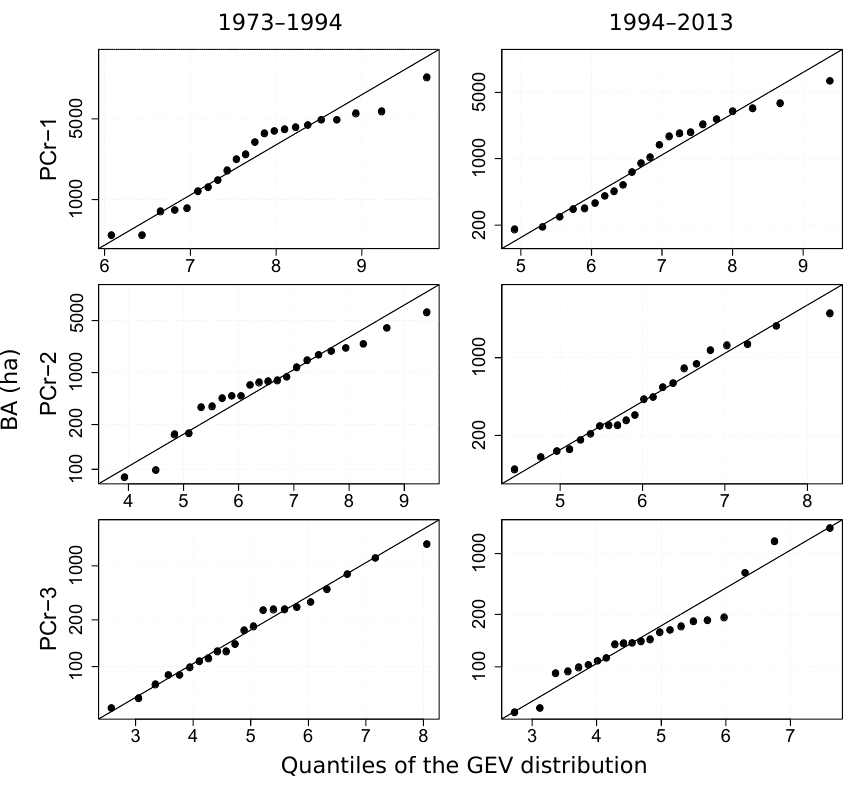
Figure 3. QQ plot of the fitted GEV distributions for each region (PCr-1, PCr-2, and PCr-3) and each period (1973–1994 and 1995–2016). Point estimates of the GEV parameters are obtained as the mean of the posterior distributions. The BA (ha) is indicated on a log-scale.